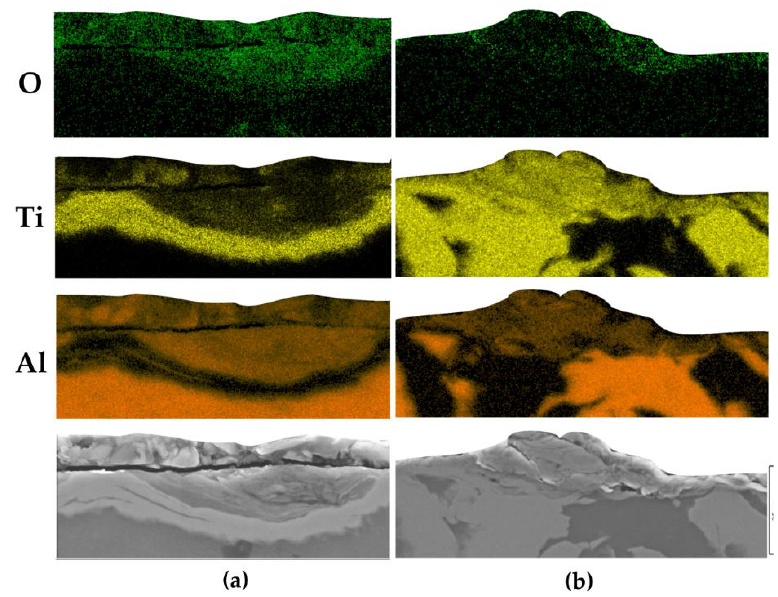
Figure 6. EDS maps of the tribolayer in cross-section. ( a ) Ti20 – AlSi, ( b ) Ti80 – AlSi.